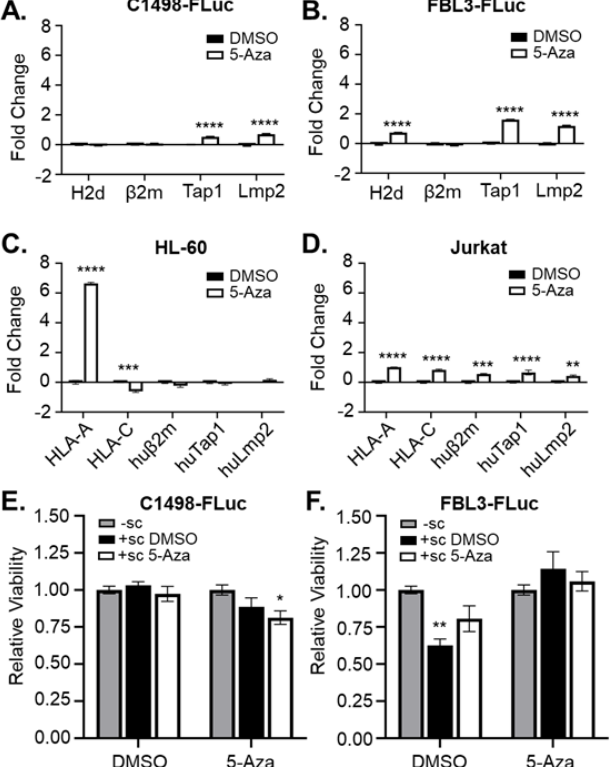
Figure 3. 5-Aza treatment rescues expression of genes related to antigen presentation. ( A ) C1498-Fluc, ( B ) FBL3-FLuc, ( C ) HL-60, and ( D ) Jurkat cells were treated for 48 h in culture with vehicle (DMSO) and 1µM 5-Aza ( A , B ) or 5µM 5-Aza ( C , D ). RNA was isolated and amplified by qPCR with primers for H2d, β 2m, Tap1, and Lmp2 ( A , B ) or HLA-A, HLA-C, hu β 2m, huTap1, huLmp2 ( C , D ). n = 3 technical replicates per group. ** p < 0.01, *** p < 0.001, **** p < 0.0001, 2-way ANOVA followed by Sidak’s test for multiple comparisons. ( E ) C1498-Fluc and ( F ) FBL3-Fluc cells were